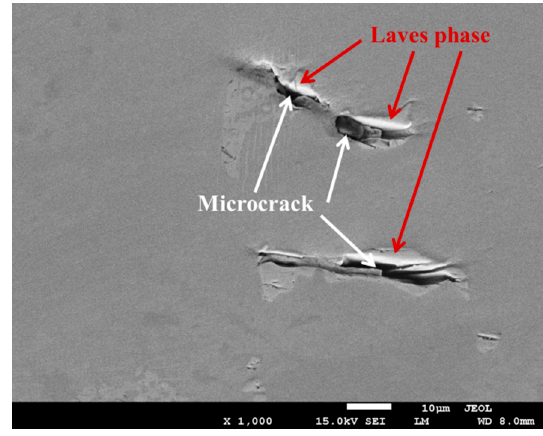
Figure 13. Back-scattered electron images of the longitudinal section from the specimen.